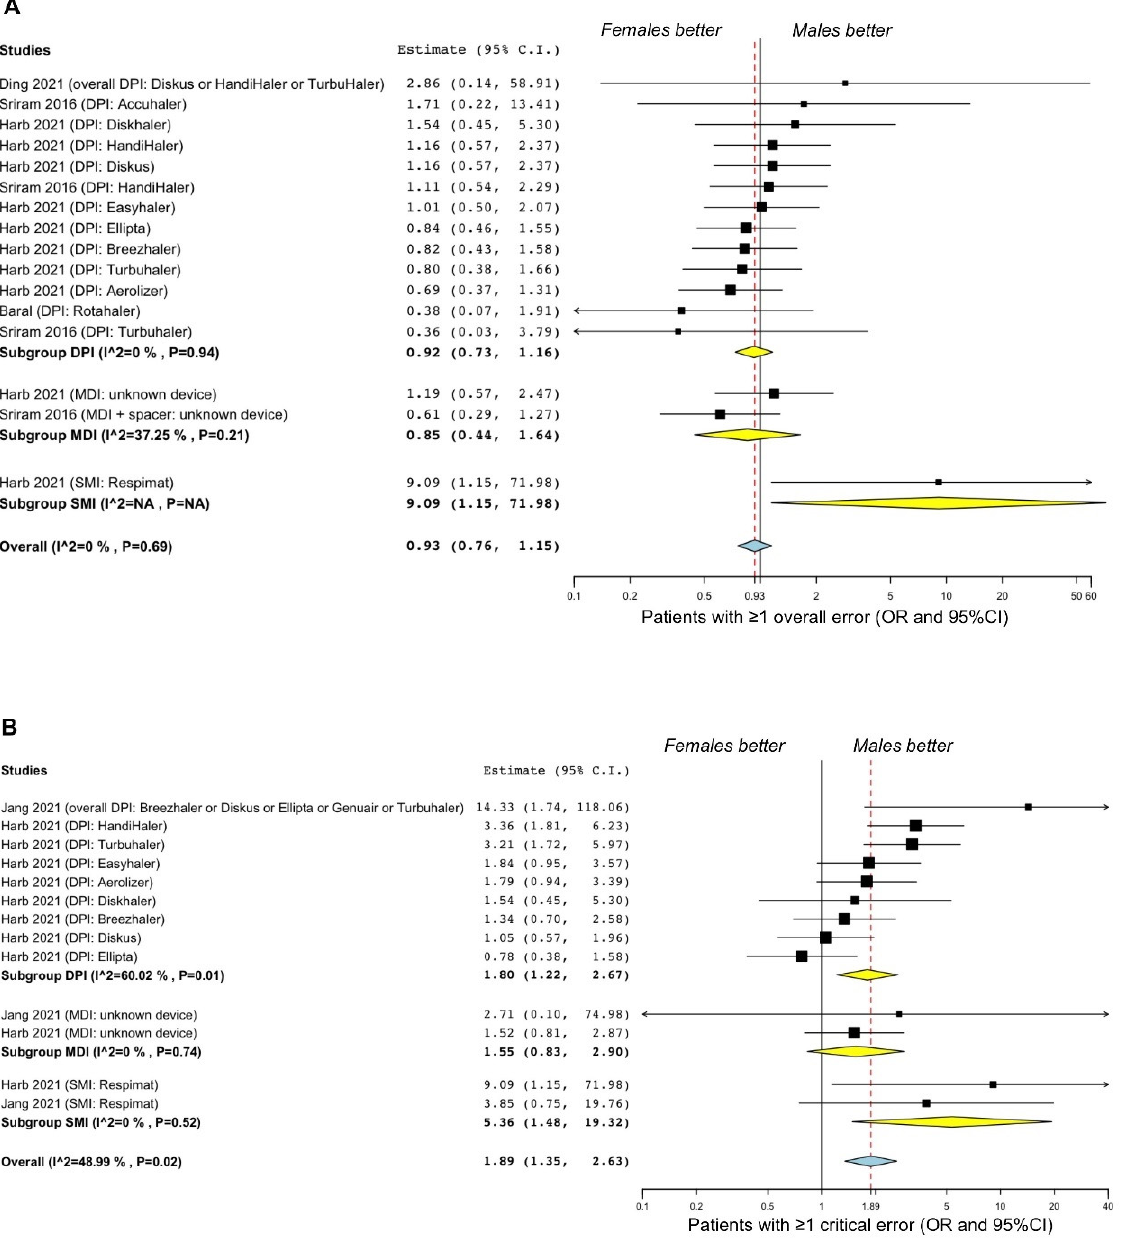
Figure 3. Forest plots of the association between the frequency of making at least one overall error ( A ) [31,54,57,58] or one critical error ( B ) [31,55] in the use of inhaler devices in COPD. DPI: dry powder inhaler; MDI: metered-dose inhaler; OR: odds ratio; SMI: soft mist inhaler; 95%CI: 95% confidence interval.